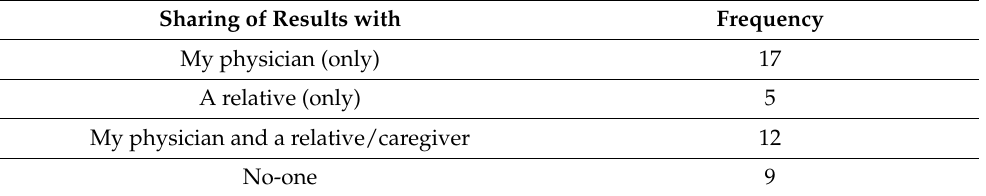
Table 5. Sharing of home health measurements results with others (select multiple answers allowed).